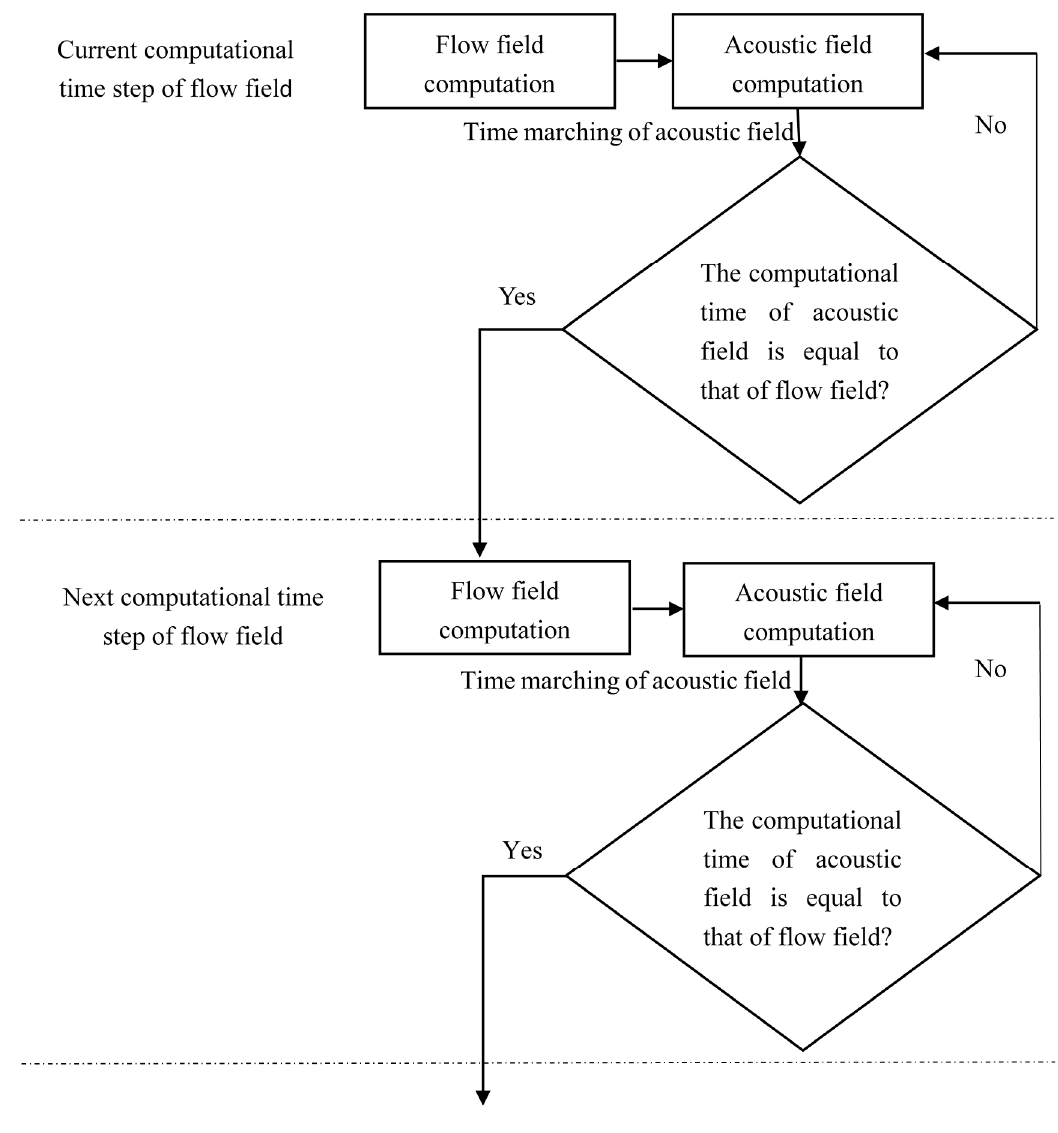
Figure 3. The calculation flow chart of flow and acoustic fields. Figure 3 . The calculation flow chart of flow and acoustic fields .